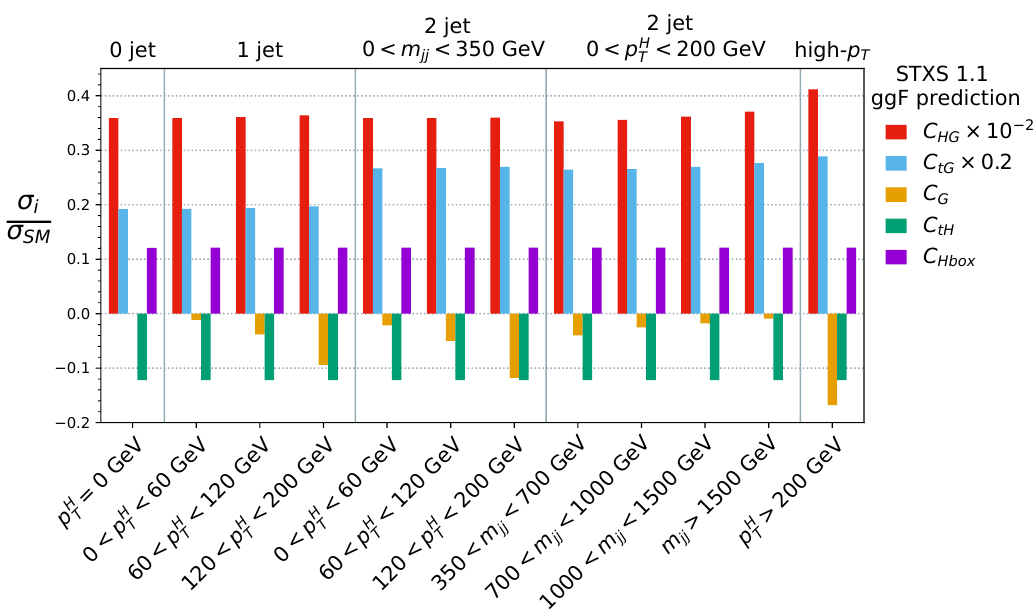
Figure 2 . Illustration of the effects of selected SMEFT operators on representative gluon-fusion simplified template cross-sections σ relative to the corresponding SM cross-sections σ i C i / Λ = 1 TeV − 2 . The various Higgs p T and m jj bins provide complementary sensitivities and hence discriminating power between the